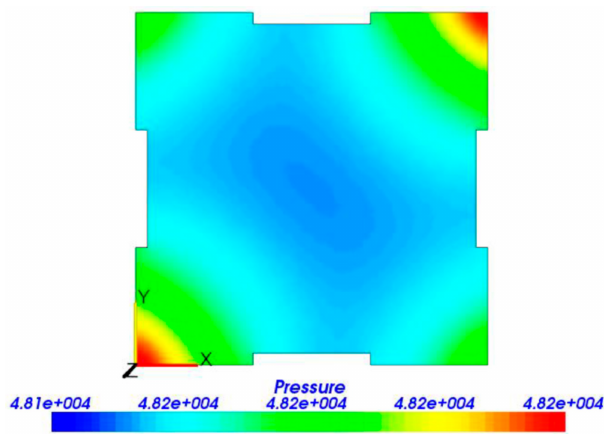
Figure 14. The temperature distribution (K).